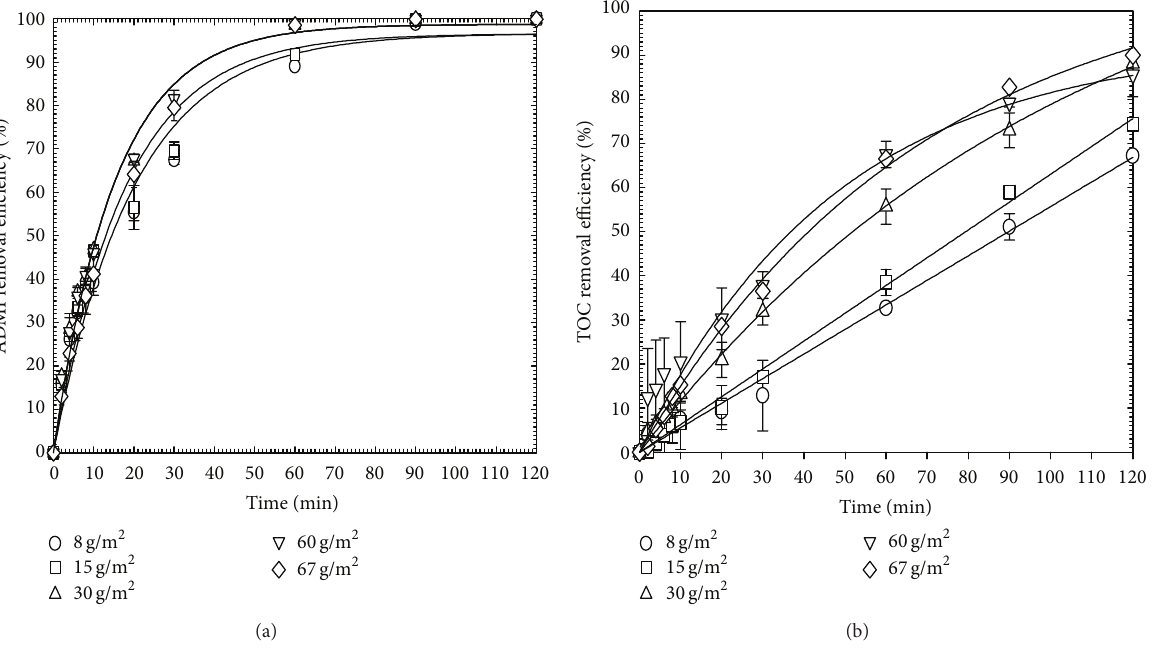
Figure 4: Effect of surface loading of ZnO. The conditions were initial dye concentration of 50mg L −1 , light intensity of 1.05mWcm −2 , and reaction time during 120